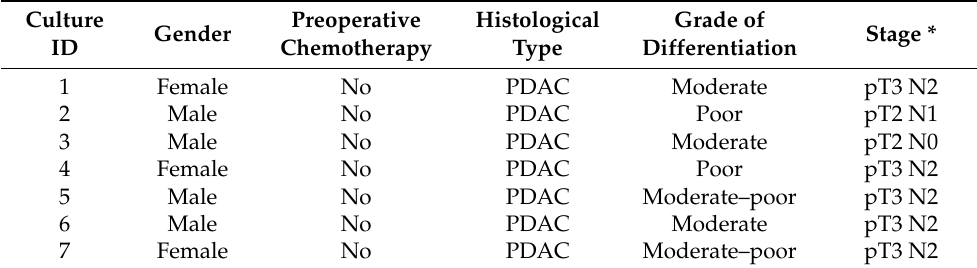
Table 1. Clinicopathological data of the study